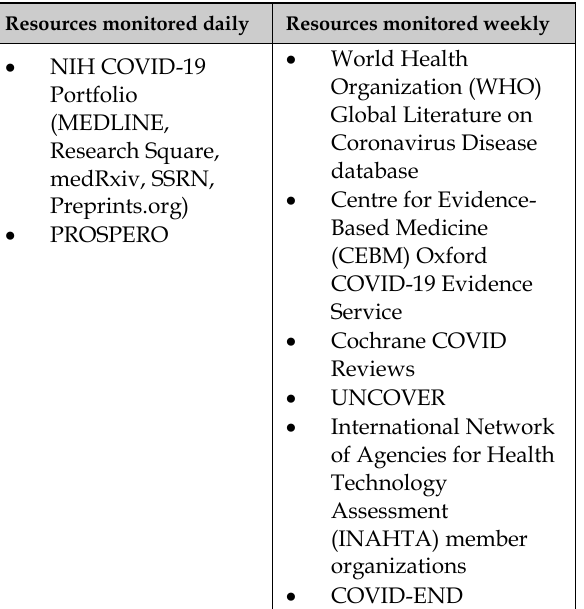
Table 1 Resources used to populate and update the COVID-